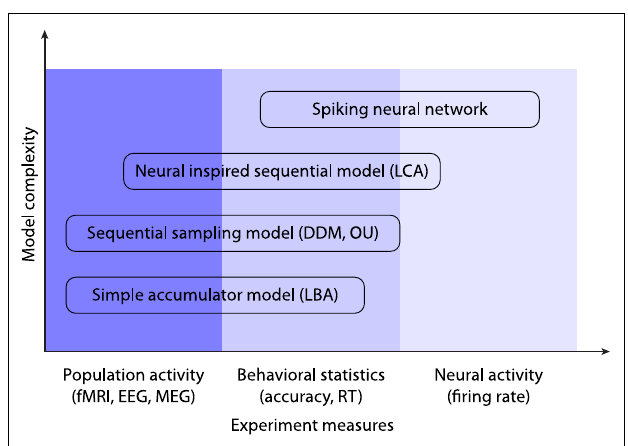
FIGURE 3 |The complexity and generality of the decision-making models. All models are capable of capturing basic behavioral statistics such as the RT and the response accuracy.The simple accumulator models and the sequential sampling models are suitable to describe the congregate activity of large neural populations (e.g., fMRI or EEG/MEG signals).The most complex model (i.e., the spiking neural network) can be used to account for dynamics of neural